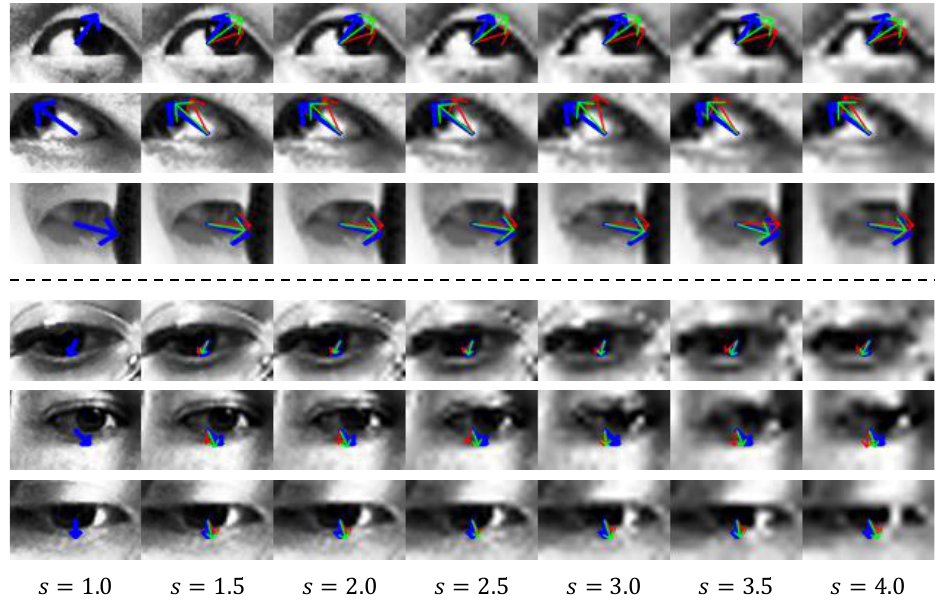
Figure 8. Gaze vector visualization. The top and bottom three rows correspond to the UTMV and MPII datasets, respectively. s denotes the scale factor. The blue arrow indicates the ground-truth gaze vector. The green and red arrows indicate estimated gaze vectors by the proposed and baseline methods,